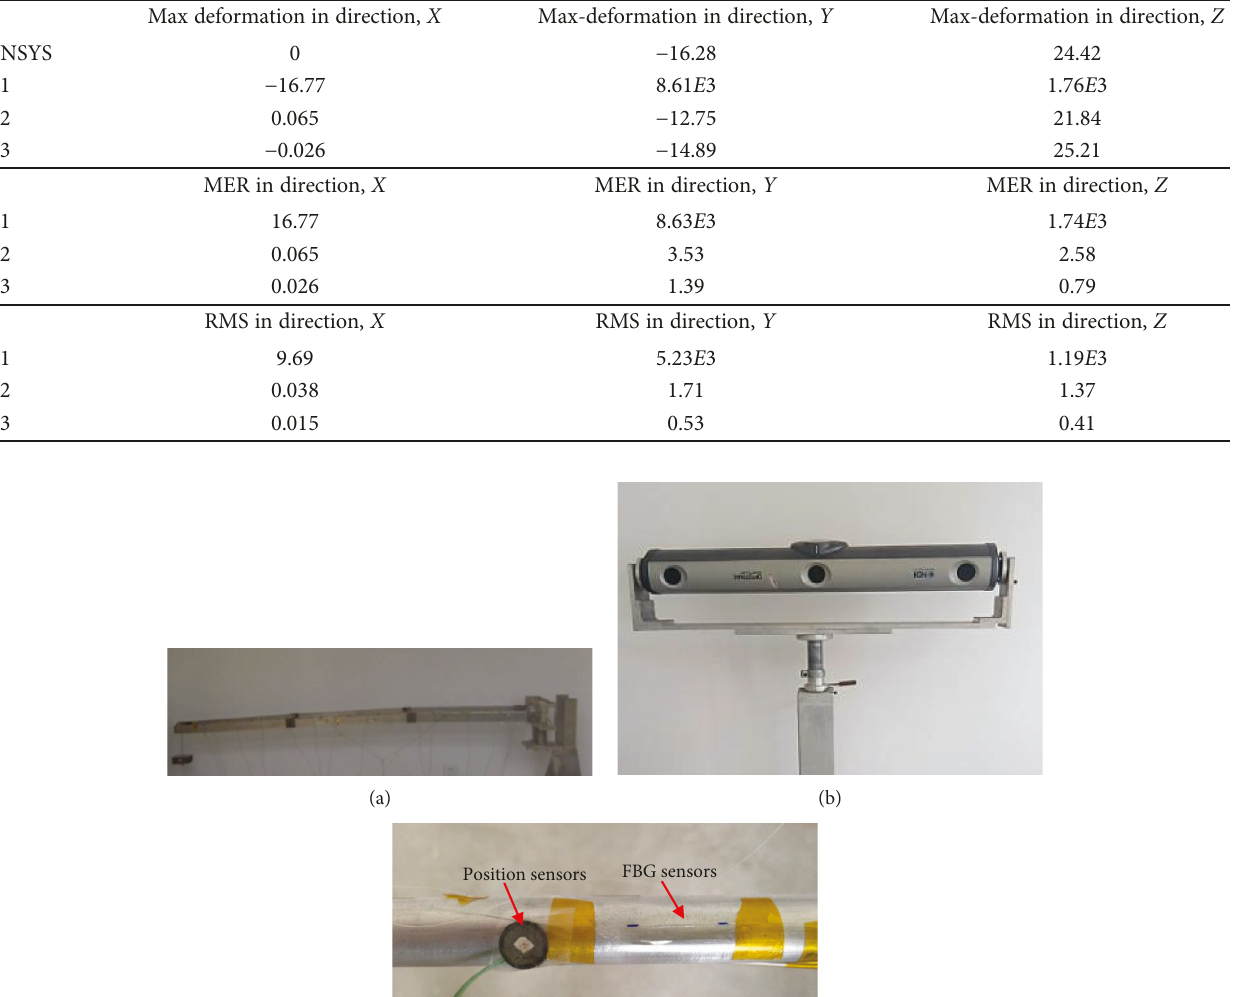
Table 3: Comparisons among deformations computed from iFEM and deformations extracted from ANSYS. Computed results contained system errors, combining errors of sensor-locations with errors of strain-measurements. Displacements expressed in mm. Max deformation in direction, X